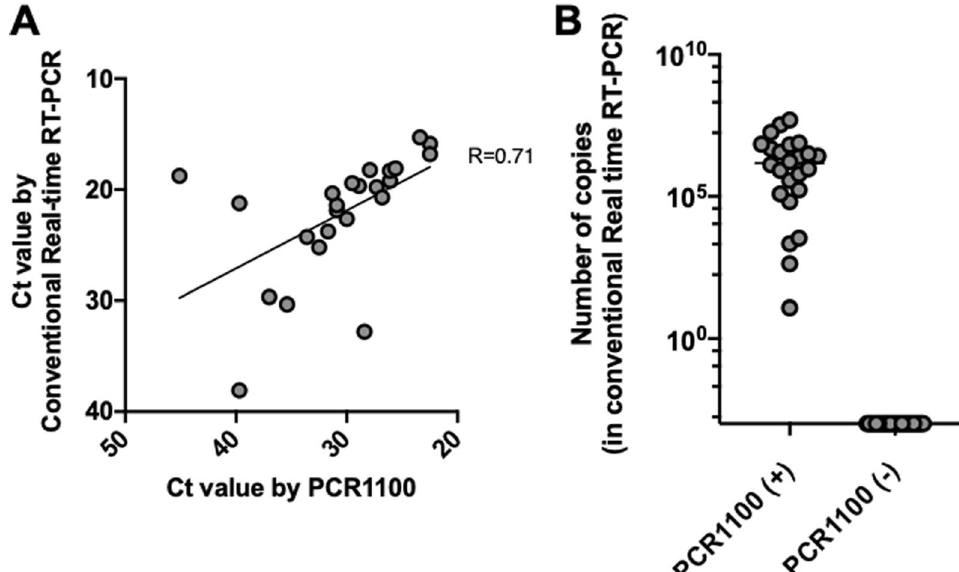
Fig. 3 Comparison of the PCR1100 assay with conventional Real-time RT-PCR using field samples. A The Ct value of the PCR1100 assay was compared to that obtained using conventional real-time RT-PCR (CFX96 Touch) across a panel of 24 RABV-positive field samples. B The results (RABV-positive and -negative) determined by PCR1100 (x-axis) and the viral RNA copy number in each specimen determined by conventional real-time RT-PCR (y-axis) are